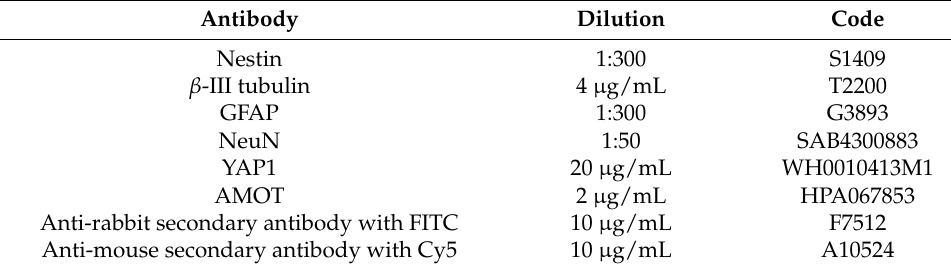
Table 2. The antibodies for